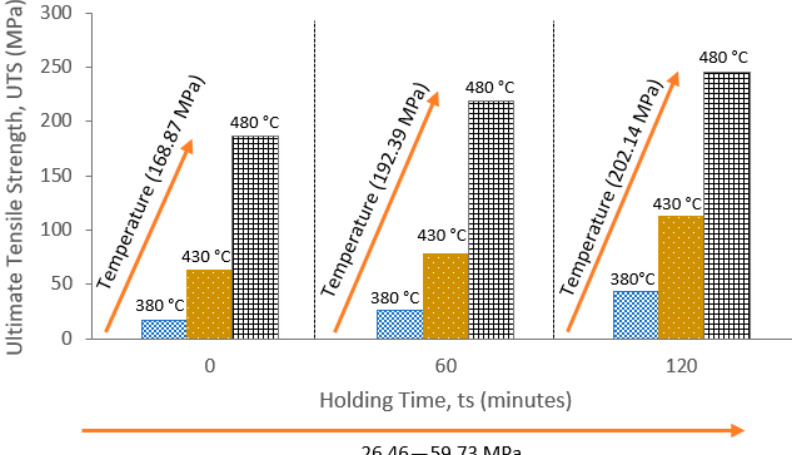
Figure 4. Ultimate tensile strength results at different working temperatures and duration.